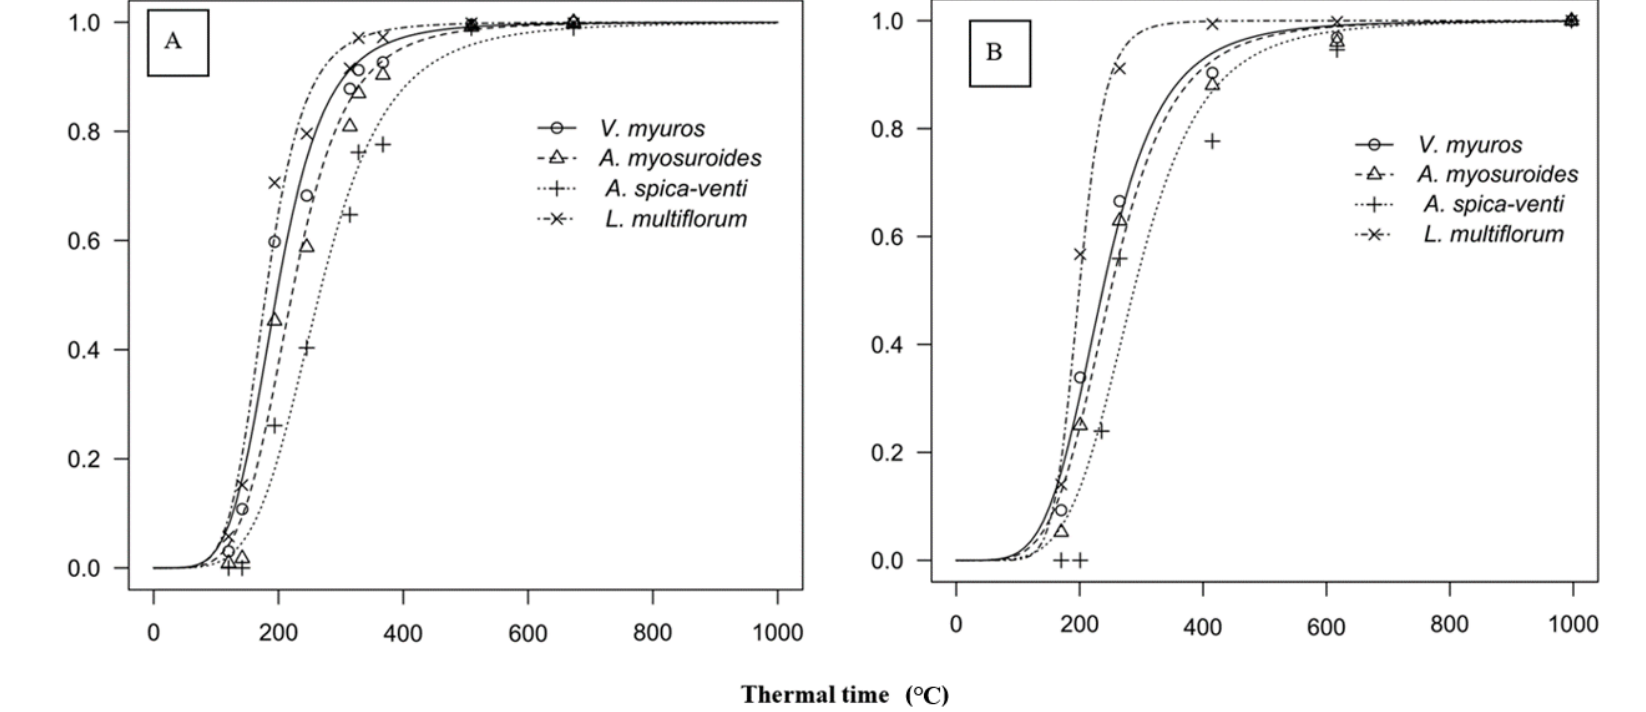
Figure 2. Cumulative emergence dynamics of grass species as a function of thermal time (°C) in 2017/18 ( A ) and 2018/19 ( B ). Regression equation and parameter estimates given in Table 1.